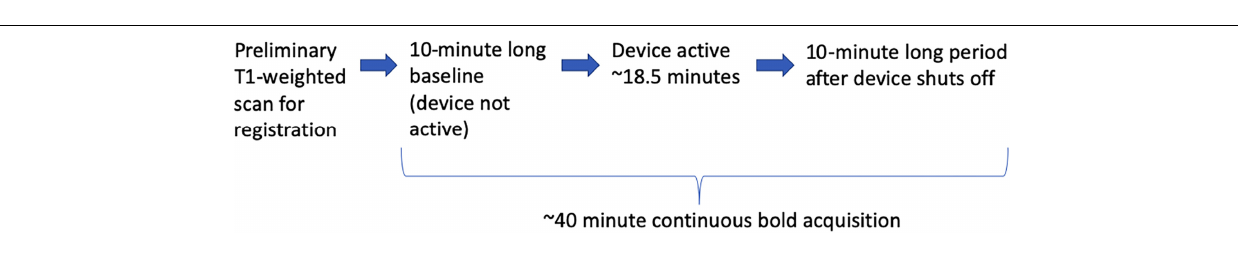
FIGURE 3 | The sequence of events during the BOLD